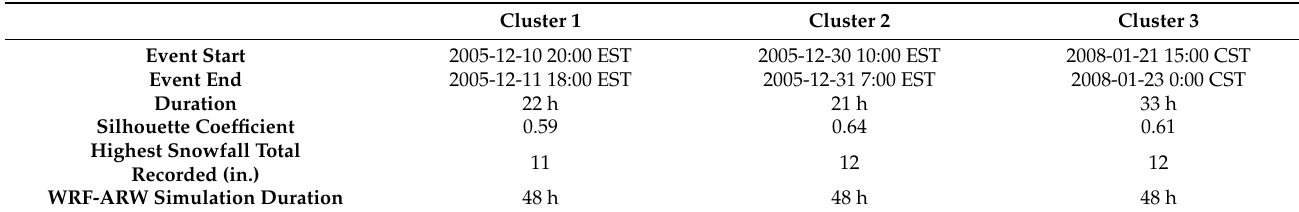
Table 4. Test cases used for WRF-ARW simulations for Lake Superior.